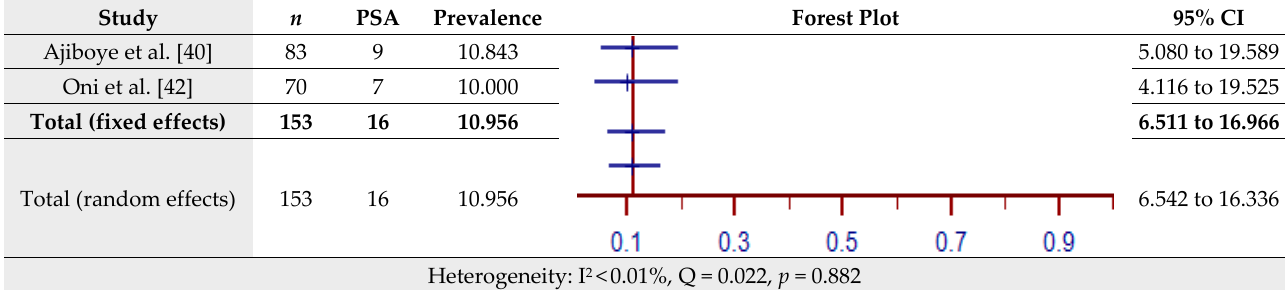
Figure 10. Prevalence estimates of Post-Stroke Anxiety (PSA) assessed by the Schedules for Clinical Assessment in Neuropsychiatry (SCAN).